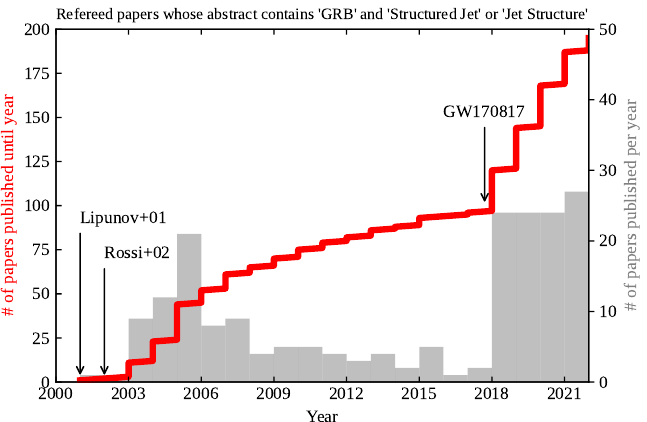
Figure 1. Timeline of scientific papers about GRB structured jets. The red solid line shows the cumulative number (shown on the left-hand axis) of refereed papers that contain “gamma-ray burst” and “structured jet” or “jet structure” in their abstract, according to the NASA ADS [28]. The grey his- togram (number shown on the right-hand axis) shows the corresponding number of papers published per year. The dates of the two seminal papers [23,24] and of the GW170817 discovery [25–27] are annotated. We note that alternative nomenclatures with respect to the ‘structured jet’/‘jet structure’ used here exist, hence the actual number of papers on the subject could be